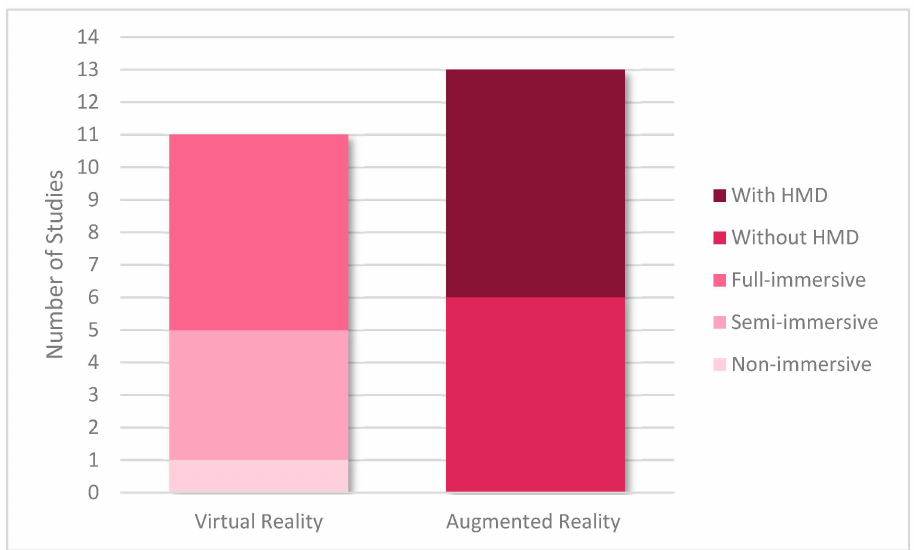
Figure 5. Illustration of included articles based on used technologies. HMD: head-mounted